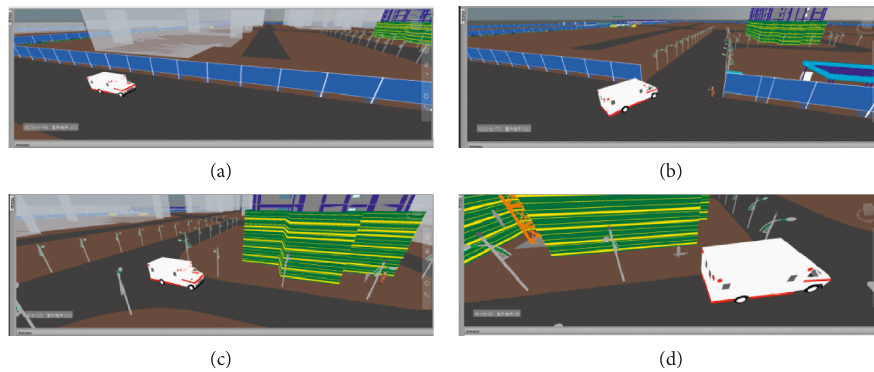
Figure 10: Schematic diagram of the animation simulation of the ambulance arrival accident